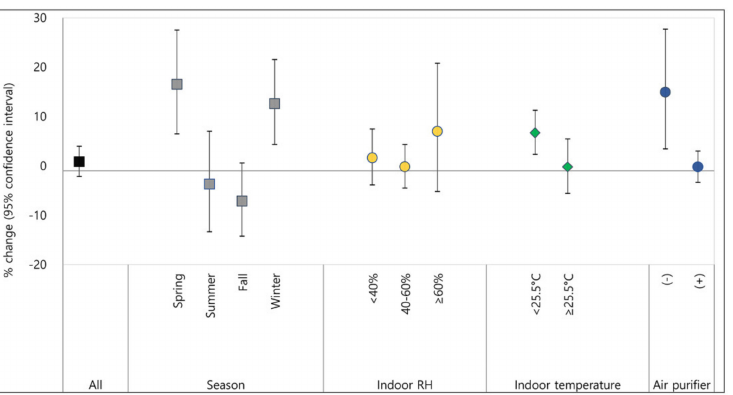
Figure 2. Percent changes of atopic dermatitis symptoms caused by PM 2.5 exposure. % change in AD symptoms per 10 µ g/m 3 of PM 2.5 exposure; dot or square indicate % change in AD symptoms per 10 µ g/m 3 of PM 2.5 exposure and lines are 95% confidence interval; RH, relative humidity.